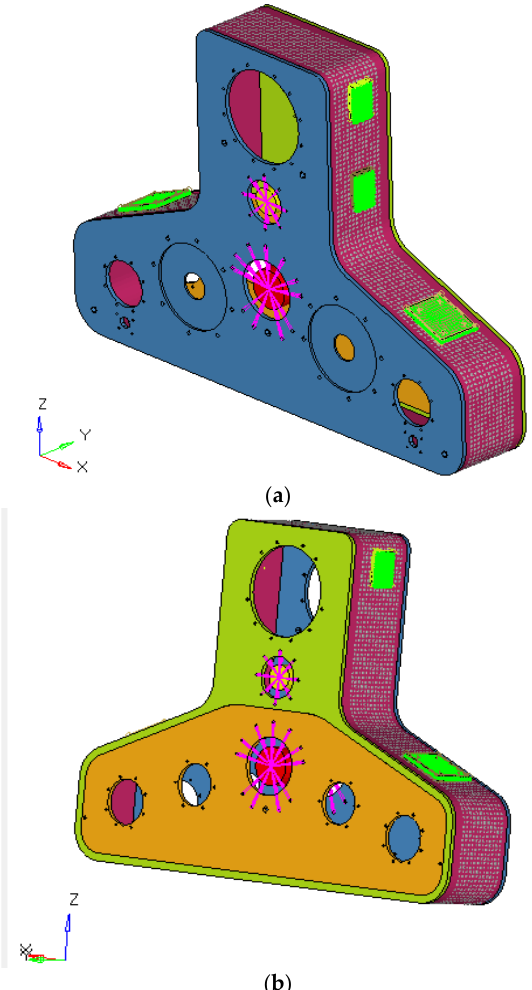
Figure 4. FEM model for the housing of adder gearbox. ( a ) Front housing; ( b ) rear housing. In the case of the adder gearbox housing, the ABAQUS program was used. Figure 5 shows the housing of the adder box with the stress field for the maximum load force along the axis of the shaft. It is observed that the maximum value of the effort is 8.82 N/mm 2 and it develops in the area of the power take-off of the box.